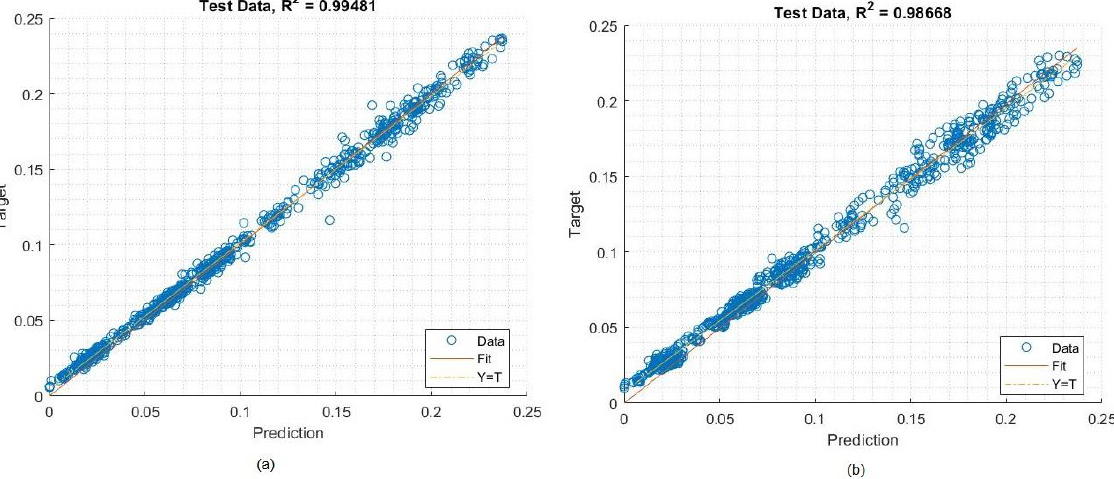
Figure 19. Squared regression plot of the deep learning models ( a ) CNN-LSTM and ( b ) LSTM during